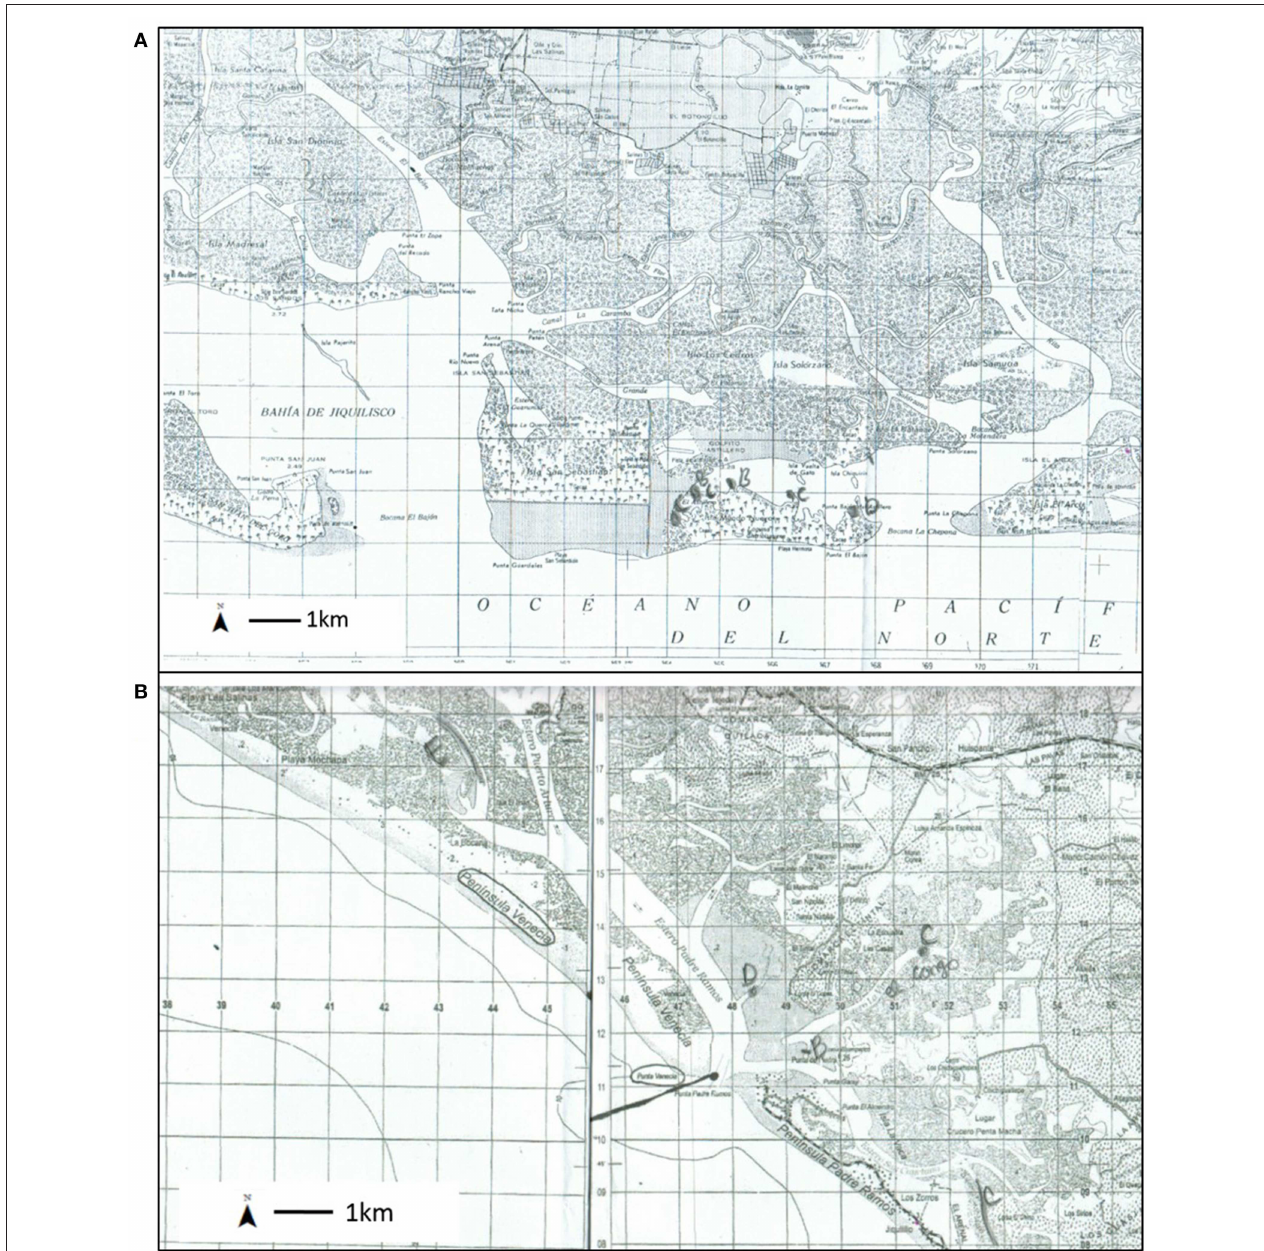
FIGURE 1 | Participatory modeling exercise results for individual interviews: (A) Interview 024 in Bahía, and (B) interview 063 in EPR. Dots and lines drawn in by informants indicate where they have seen hawksbill turtles in the water (as opposed to nesting), and letters refer to the size class of hawksbills seen at indicated points. Letters refer to the cardboard cutouts that were provided to create consistency when referencing